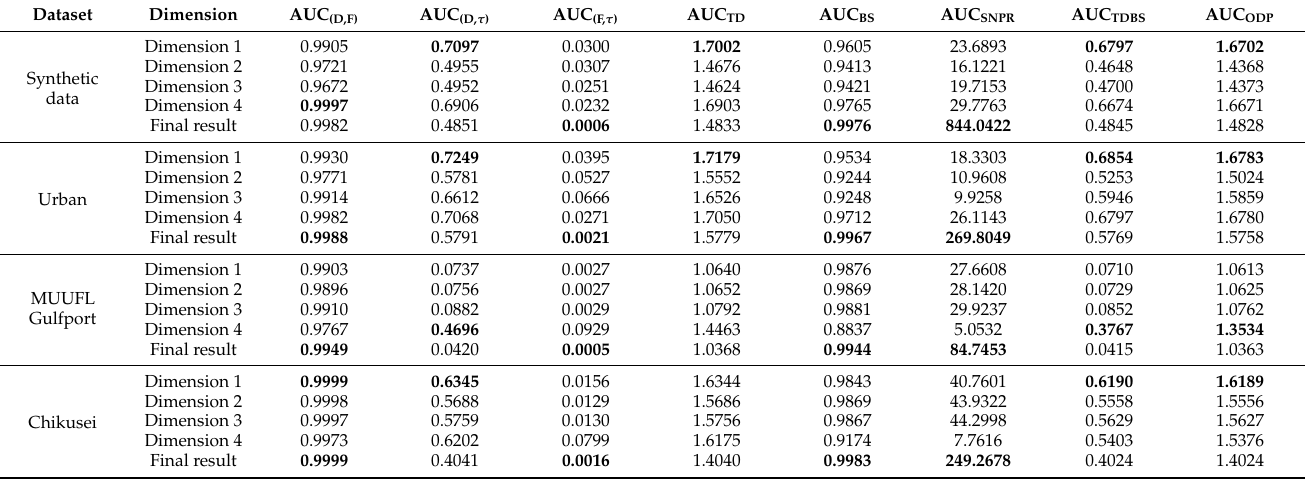
Table 6. Comparison of AUC performance of different dimensions on various datasets.